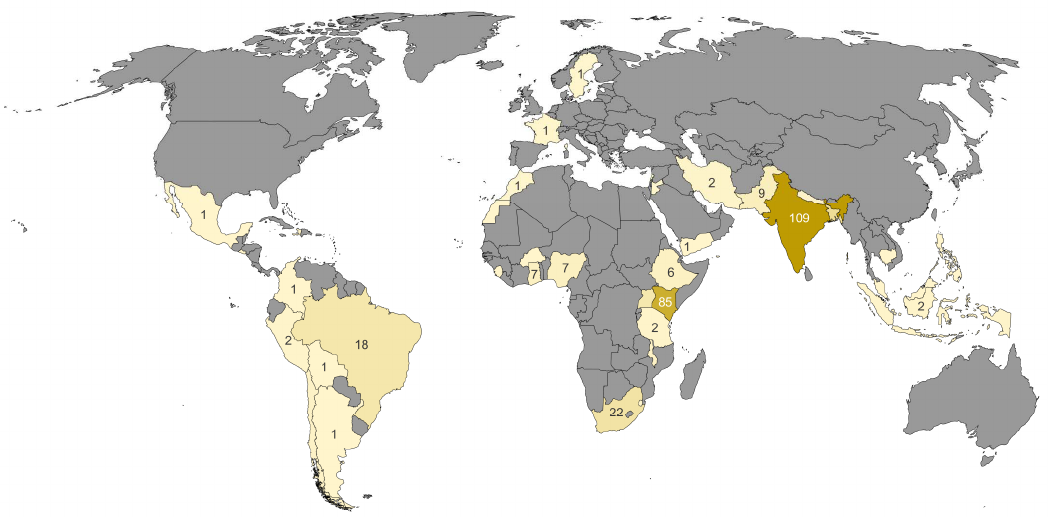
Figure 4. Number of studies on slum health in the respective countries. Cross-national and global studies are not